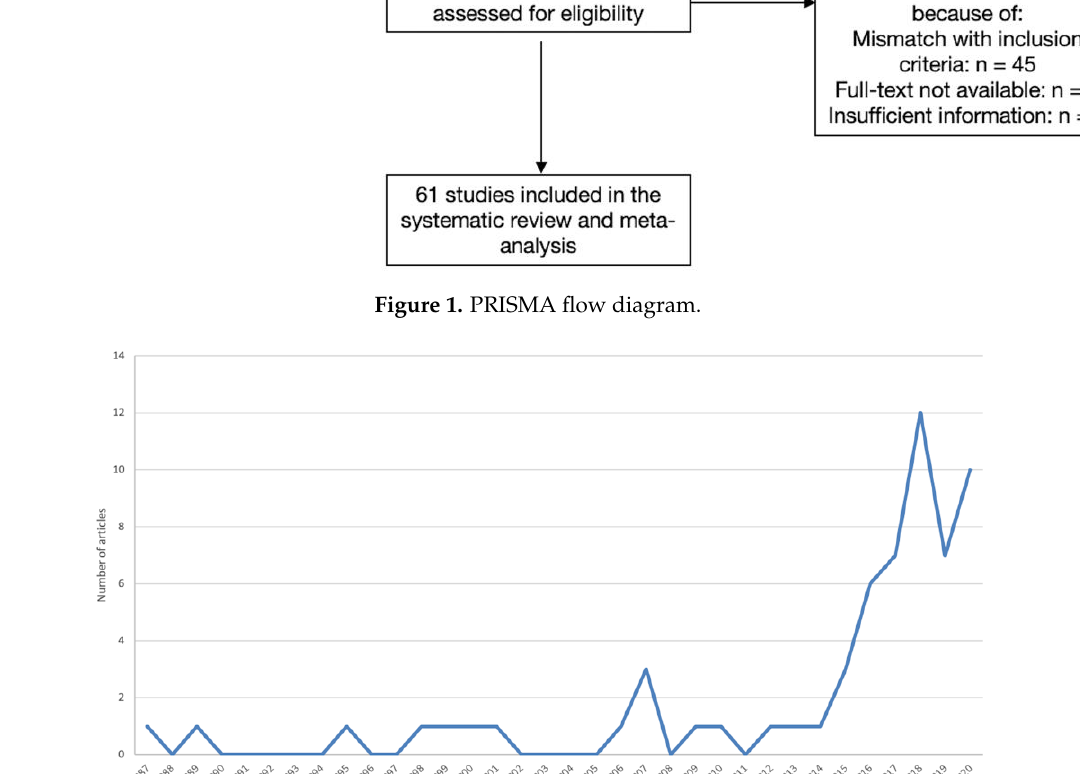
Figure 2. Publishing timeline of the included studies.